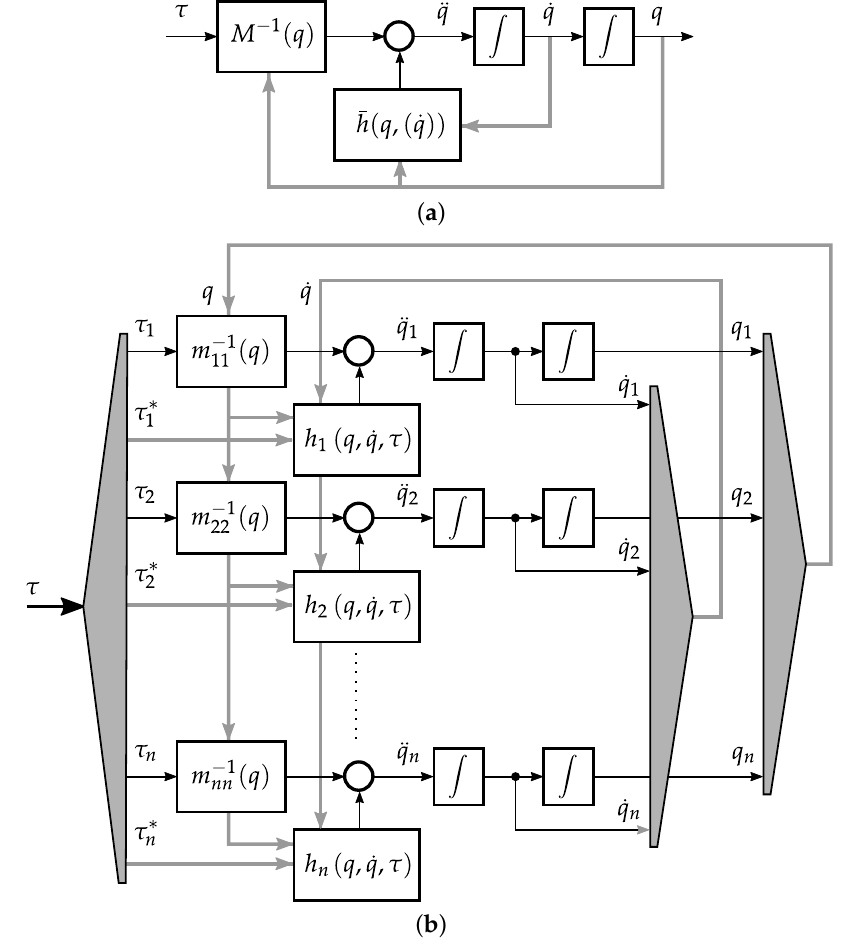
Figure 1. Block diagrams of the considered fully actuated mechanical system: ( a ) centralized model (2) with ¯ h : = M − 1 ( q ) ( − C ( q , ˙ q ) ˙ q − G ( q ) − F ( ˙ q )) , ( b ) distributed model which consists of n subsystems defined by (3) where τ ∗ : = W i τ i